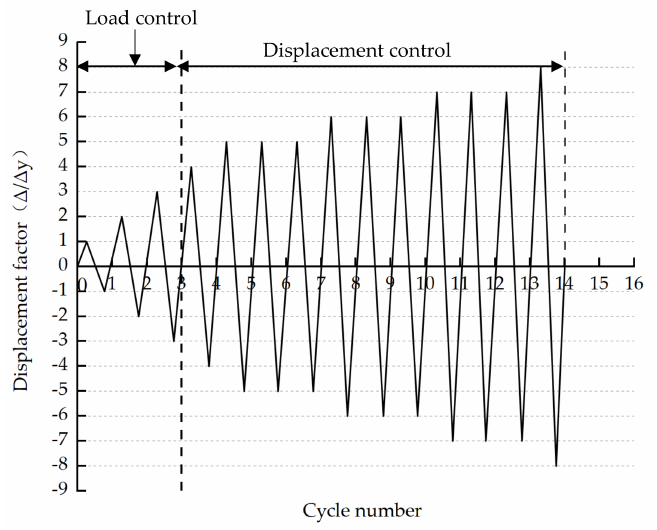
Figure 9. Cyclic lateral loading